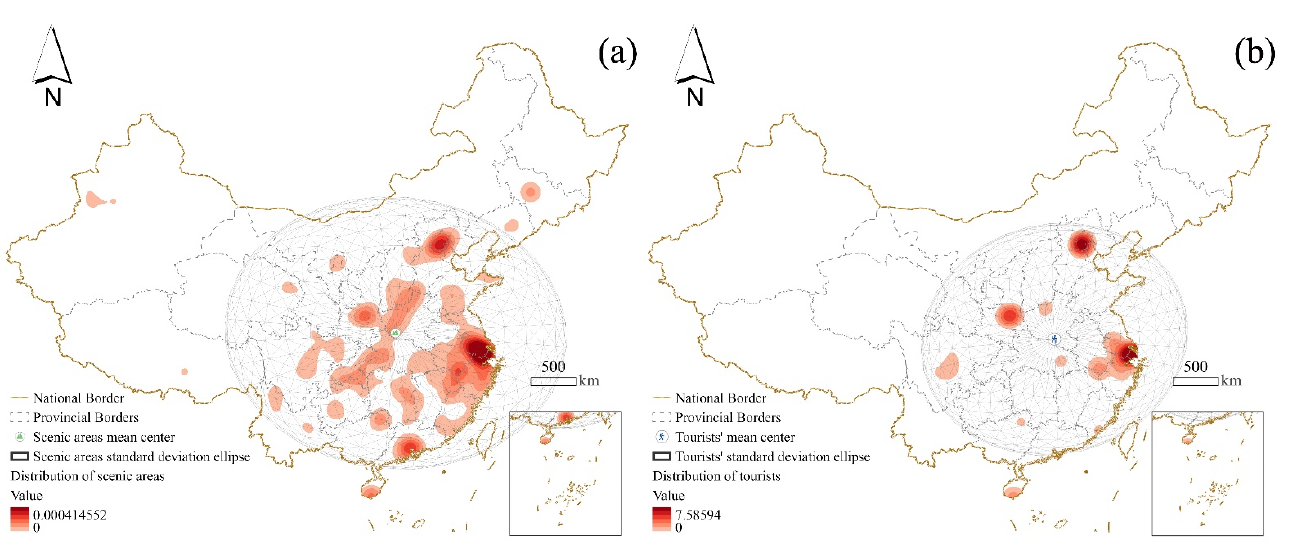
Table 3. Landscape distribution and tourist distribution standard deviation ellipse